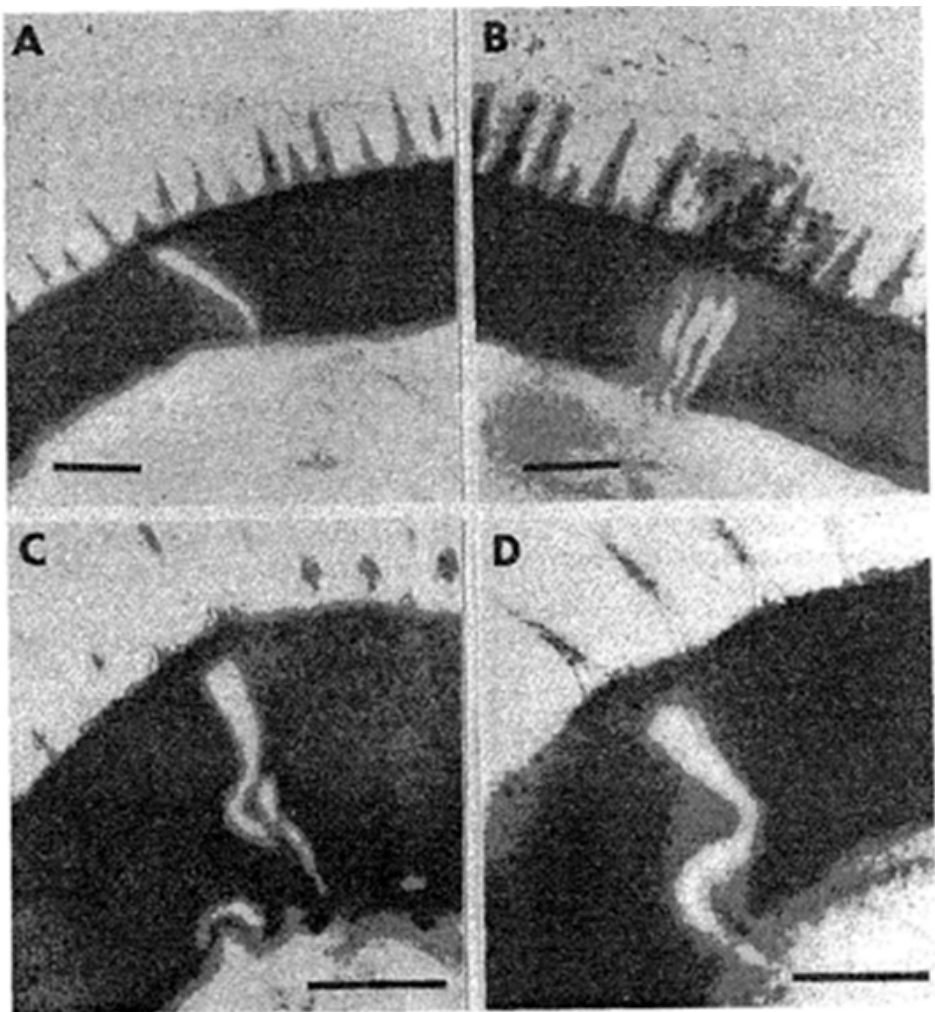
Figure 3. Hatching lines in the S. mansoni egg. ( A ) Transverse lamellae; ( B ) oblique longitudinal lamellae; ( C , D ) oblique transverse sections of the electron-lucid lamella in the eggshell proper. Bar length = 0.2 µm (reproduced from Helminthologia with permission).